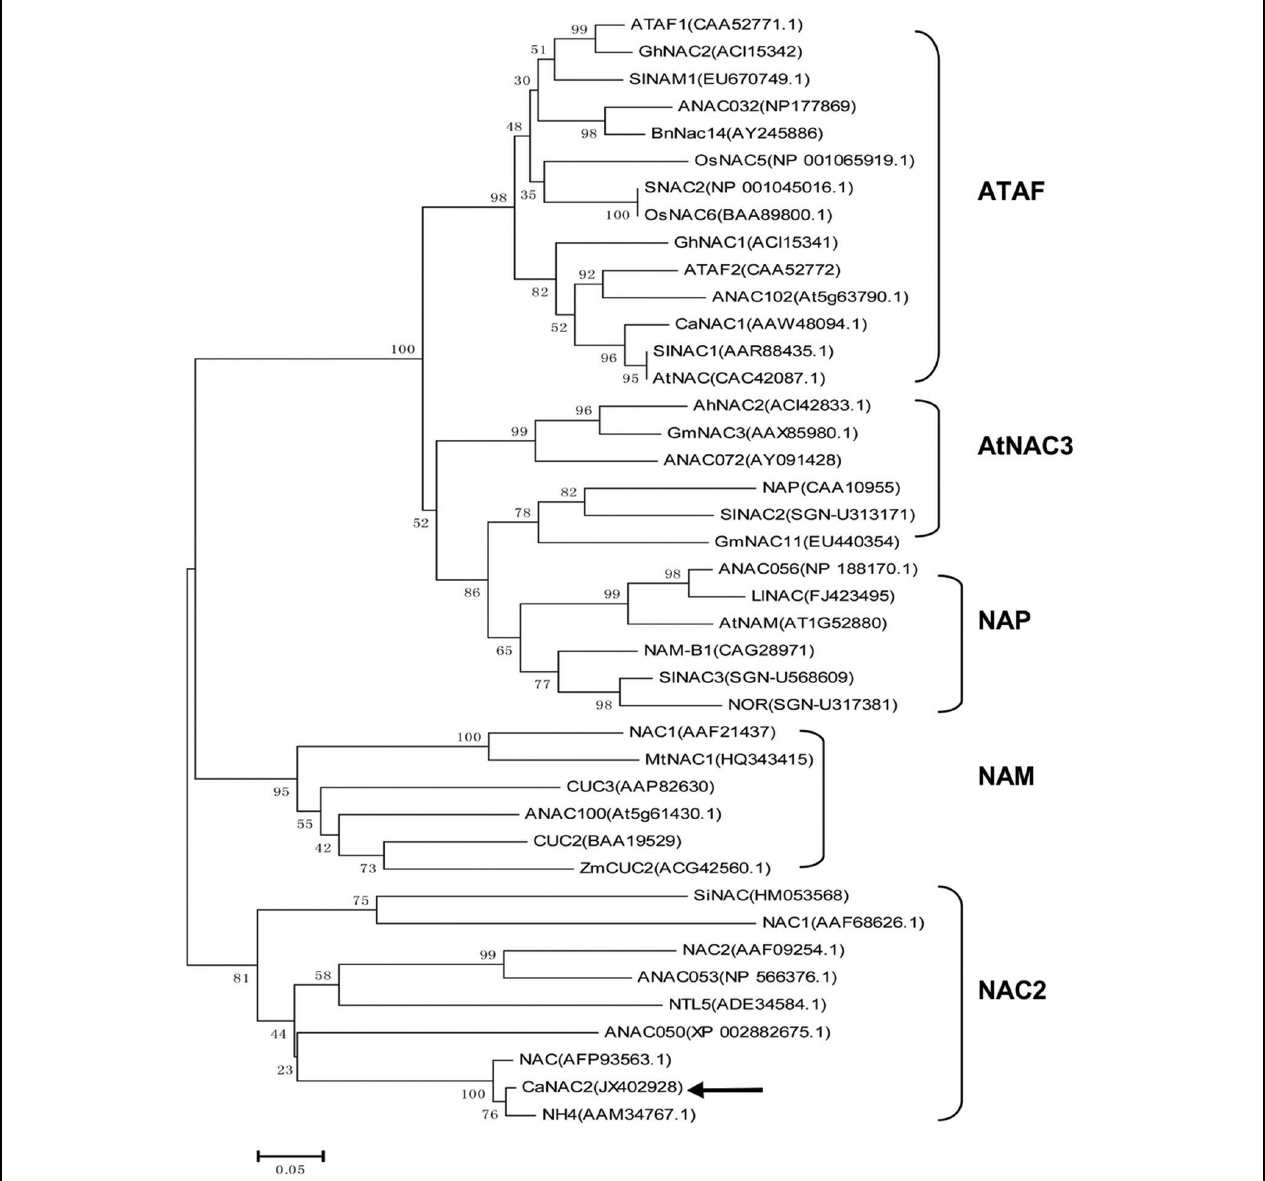
FIGURE 1 | A Neighbor-joining phylogenetic tree of CaNAC2 and NAC proteins from different plant species. The GenBank accession No. of NAC proteins are shown in the brackets. The CaNAC2 protein is marked with arrow. The NAC subgroup names are shown to the right of square.